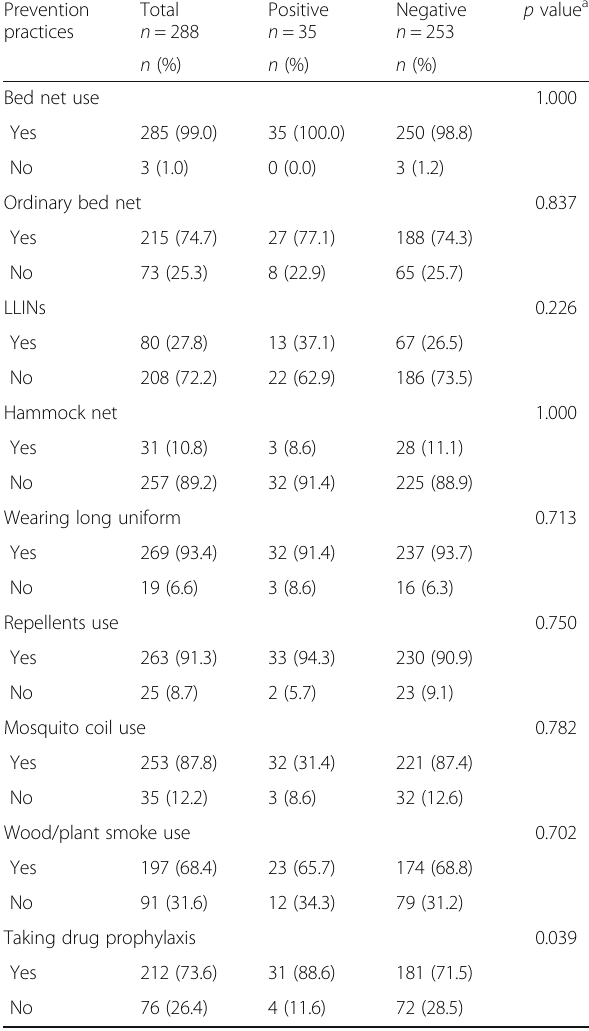
Table 5 Preventive measure of malaria among study